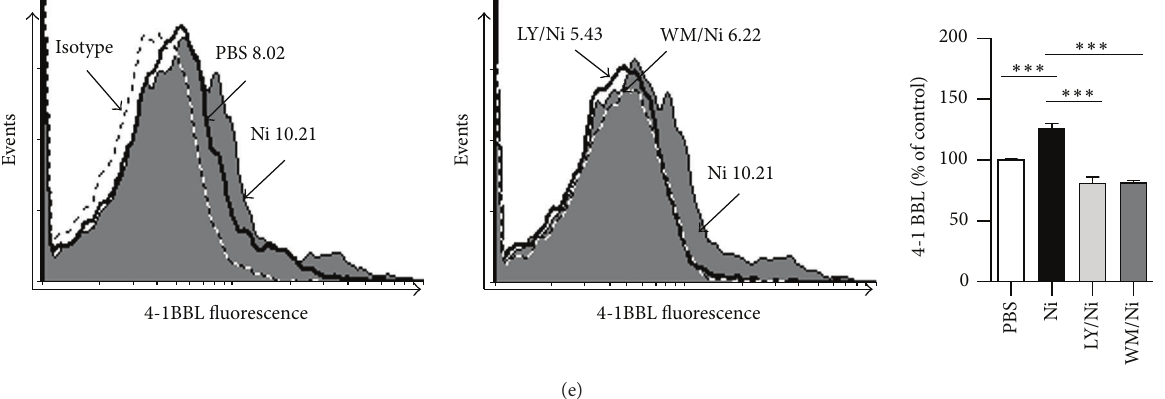
Figure 6: Nicotine increases surface molecule expression in human semimature DCs by activating Akt-S6 pathway. (a–e) DCs derived from human PBMC with human GM-CSF and IL-4 were conferred with LY294002 (10 𝜇 mol/L) or Wortmannin (10 𝜇 mol/L) 2h prior to 12 ∼ 15h nicotine (10 −7 mol/L) stimulation. The effect of Akt inhibition on nicotine-increased expression of CD80 (a), MHC class I (b), MHC class II (c), CD86 (d), and 4-1BBL (e) was determined by flow cytometry. Numbers in histogram indicated mean fluorescence intensity (MFI) of test samples. Data were given as mean ± SEM, one-way ANOVA with post Newman-Keuls test. ∗ 𝑃 < 0.05 , ∗∗ 𝑃 < 0.01 , and ∗∗∗ 𝑃 < 0.001 . One representative from 3 independent experiments is shown. Ni: nicotine; LY: LY294002; WM (Wort):